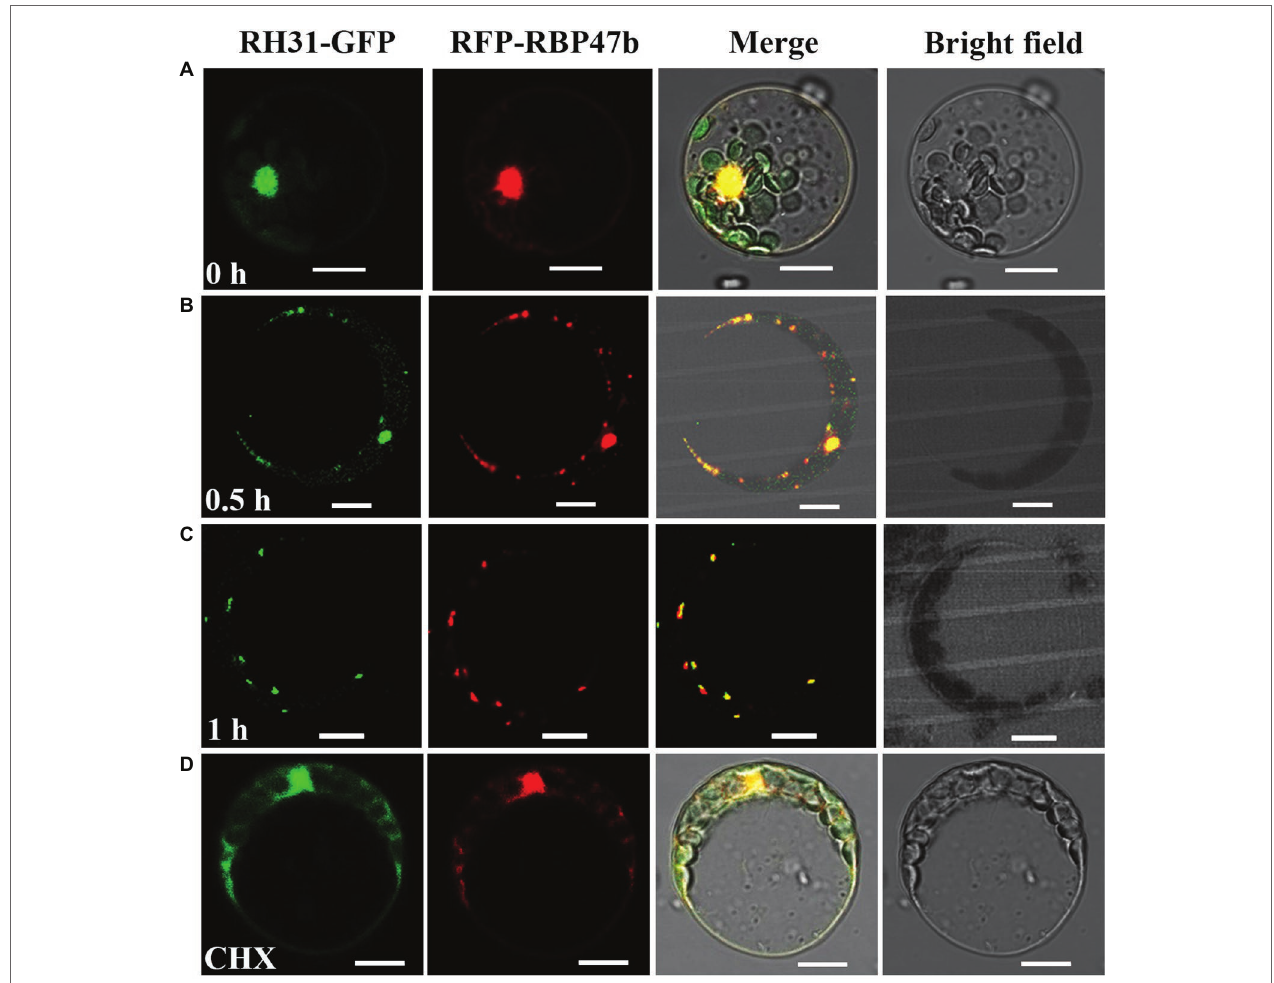
FIGURE 3 | Co-localization analysis of RH31-GFP and RFP-RBP47 in SGs under salt stress in Arabidopsis mesophyll protoplasts. (A) RH31-GFP and RFP-RBP47 mainly located in nucleus under normal condition. Scale bars = 10 μ m. (B,C) RH31-GFP and RFP-RBP47 relocated to cytoplasmic granules in response to 150 mM NaCl in different time point, and RH31-GFP fluorescence overlapped with RFP-RBP47 fluorescence. Scale bars = 10 μ m. (D) After CHX treatment, there were no cytoplasmic granules when treated protoplasts with 150 mM NaCl. Scale bars = 10 μ m. CHX,